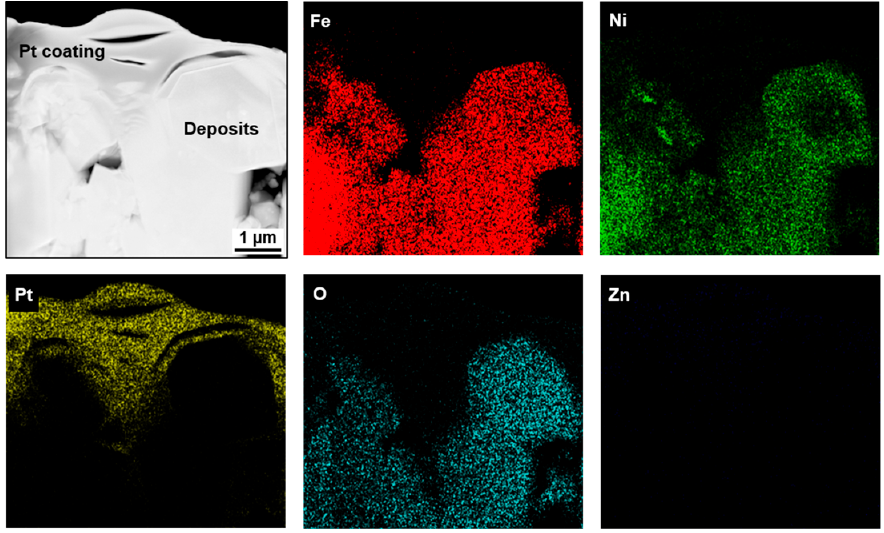
Figure 7. STEM image and EDS elemental mapping of fuel deposits formed under the condition of Case #3.